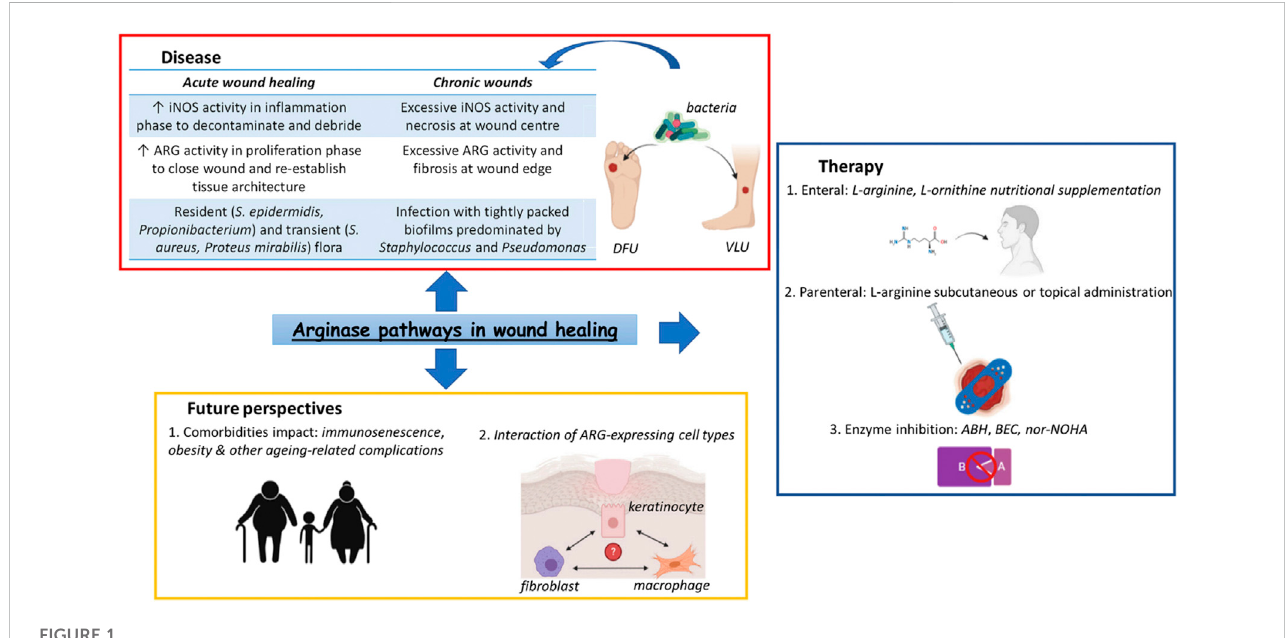
FIGURE 1 Arginase pathways in wound healing (Szondi, Wong, et al.,